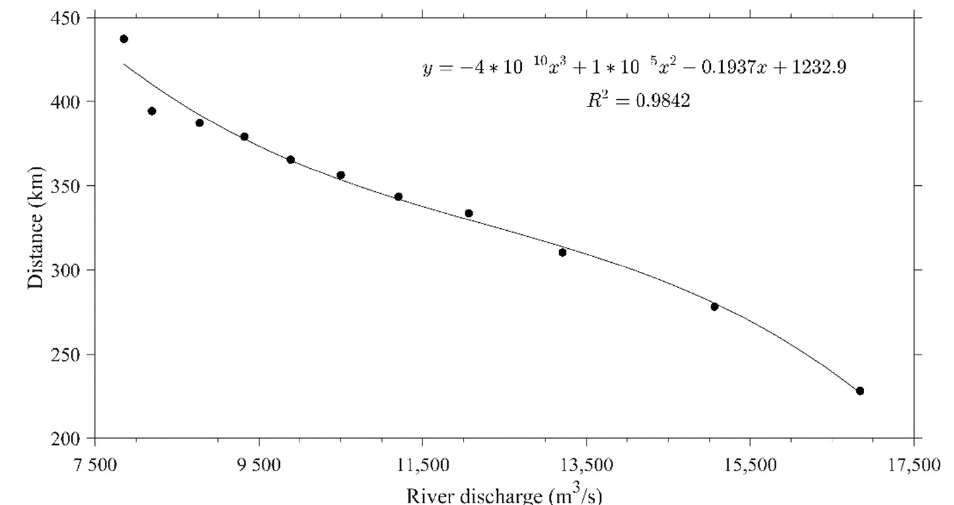
Figure 7. Relationship between the tidal current limit and the river discharge in the Changjiang River’s estuary in the dry season.